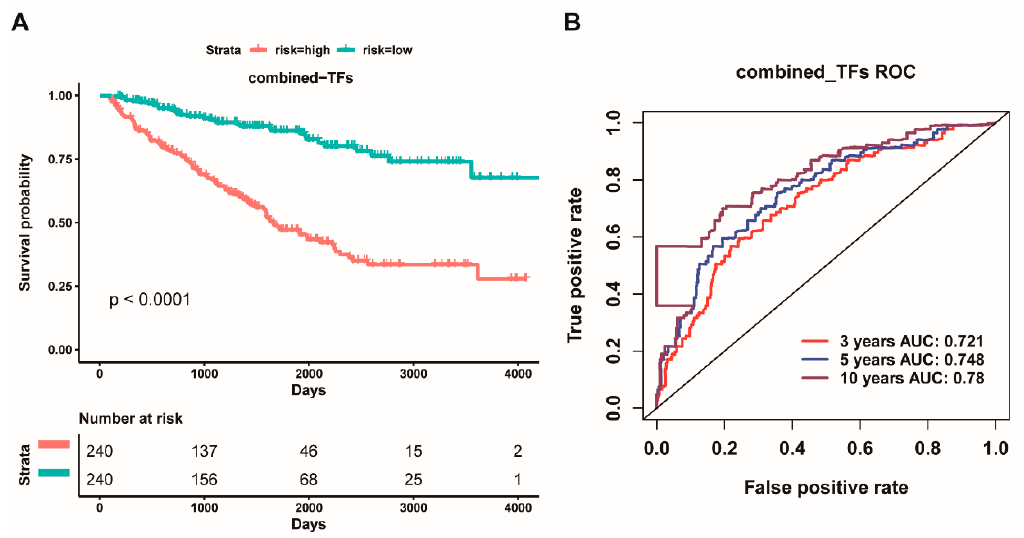
Figure 8. Kaplan Meier survival and ROC curves based on the risk score of the combined nine transcription factors as a signature. ( A ): Overall survival curves for high-risk and low-risk groups based on the prognostic model of a nine-TF signature; ( B ): ROC curves for high and low risk from the prognostic model of a nine-TF signature.